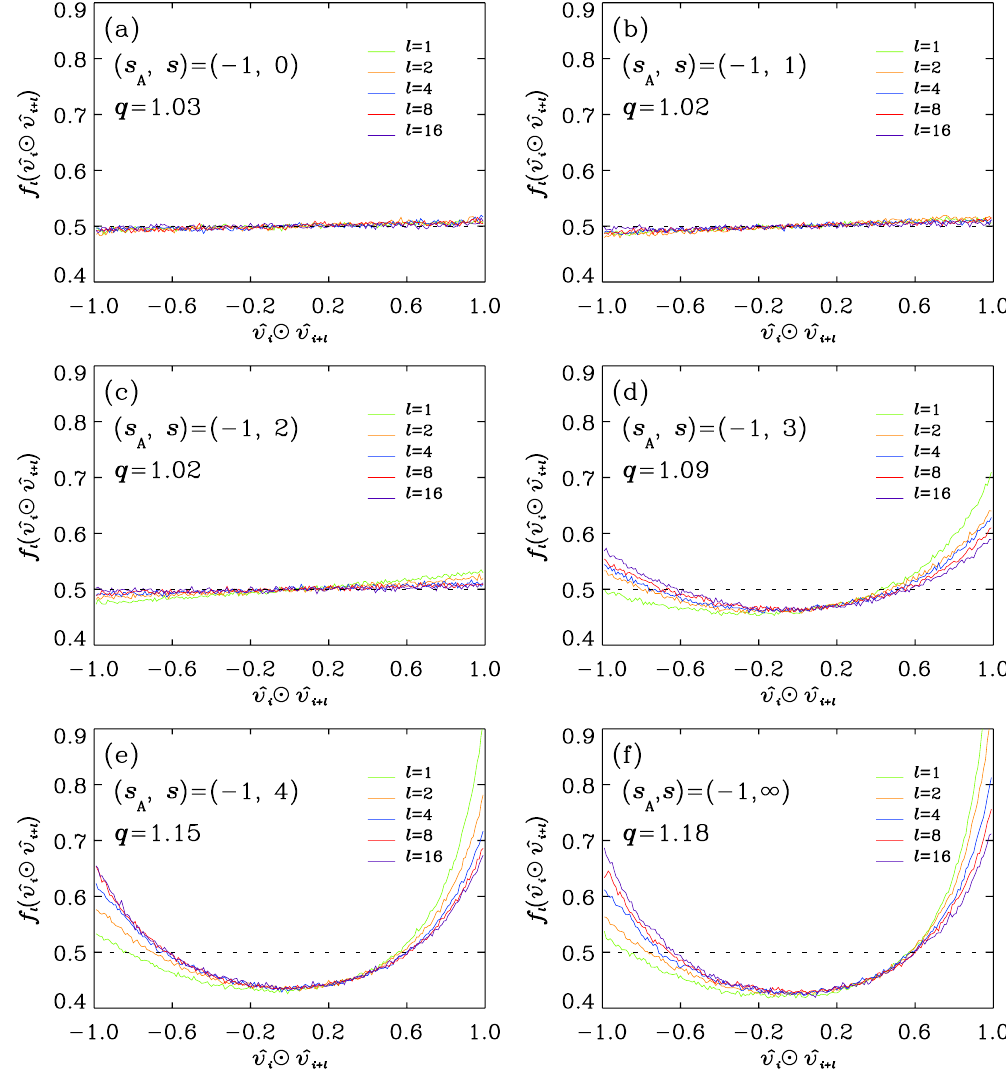
= ⋅ = ⋅ = 1, 2, 4, 8 and Figure 4. Typical distributions f l of the cosine +  ˆ ˆ v v + + ˆ ˆ v v ( ) i i l i l + ˆ ˆ v v ( ) i i l i (Fig. 1(b)) for l i i l 16, observed in the curved coordinates, for mixture systems described in Fig. 2(a), with stiffness indices ( a ) s = 0, ( b ) s = 1, ( c ) s = 2, ( d ) s = 3, ( e ) s = 4 and ( f ) s = ∞ , respectively. Data are averaged over 10000 snapshots, collected over a period 0.25 τ (see Methods ). The dashed horizontal line marks the uniform distribution = . +  ˆ for the fully isotropic situation. We also list the values for the corresponding q -parameter obtained by the fittings of the generalized Maxwell-Boltzmann (GMB) speed distributions (Eq.